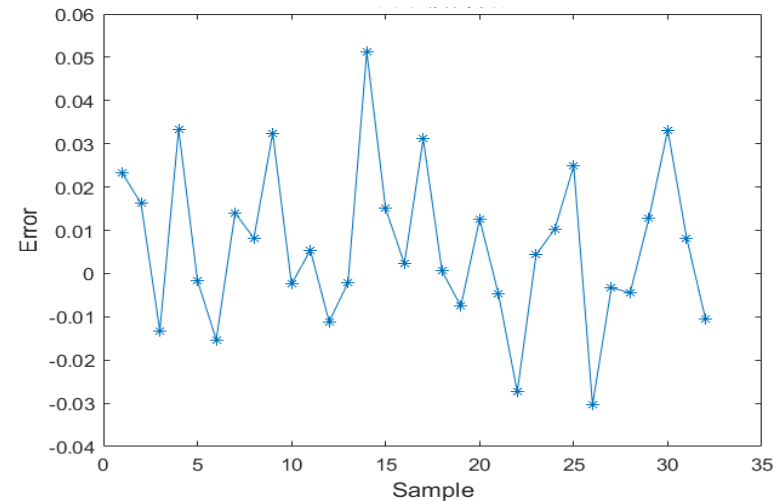
Figure 3. The error of BP neural network.